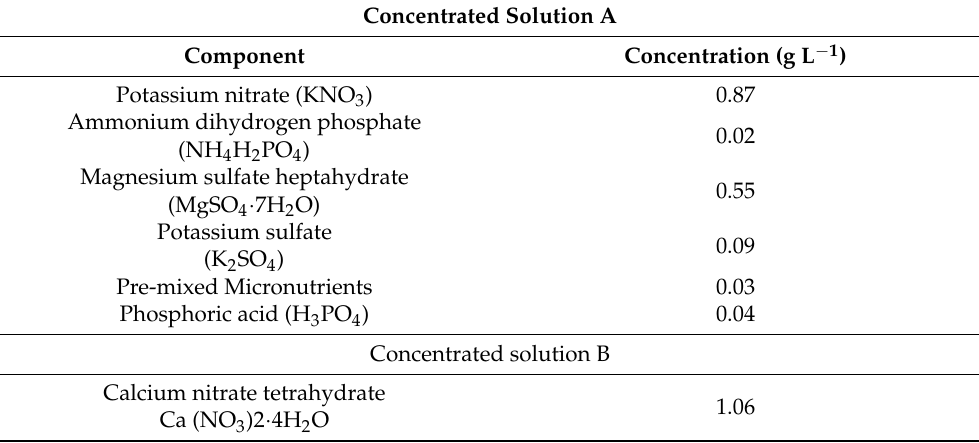
Table 1. Concentrated nutrient solution